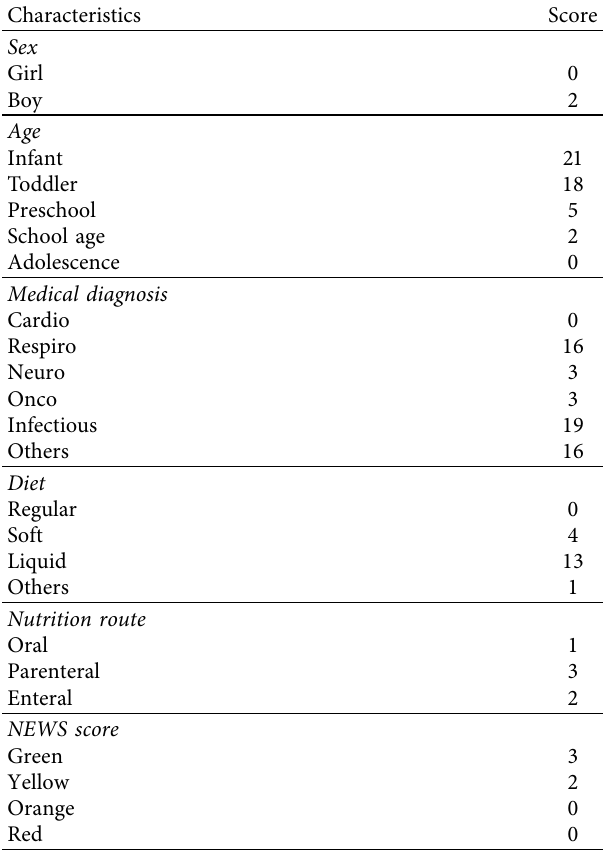
members as to which patients need more attention on their experience nutritional status decline.